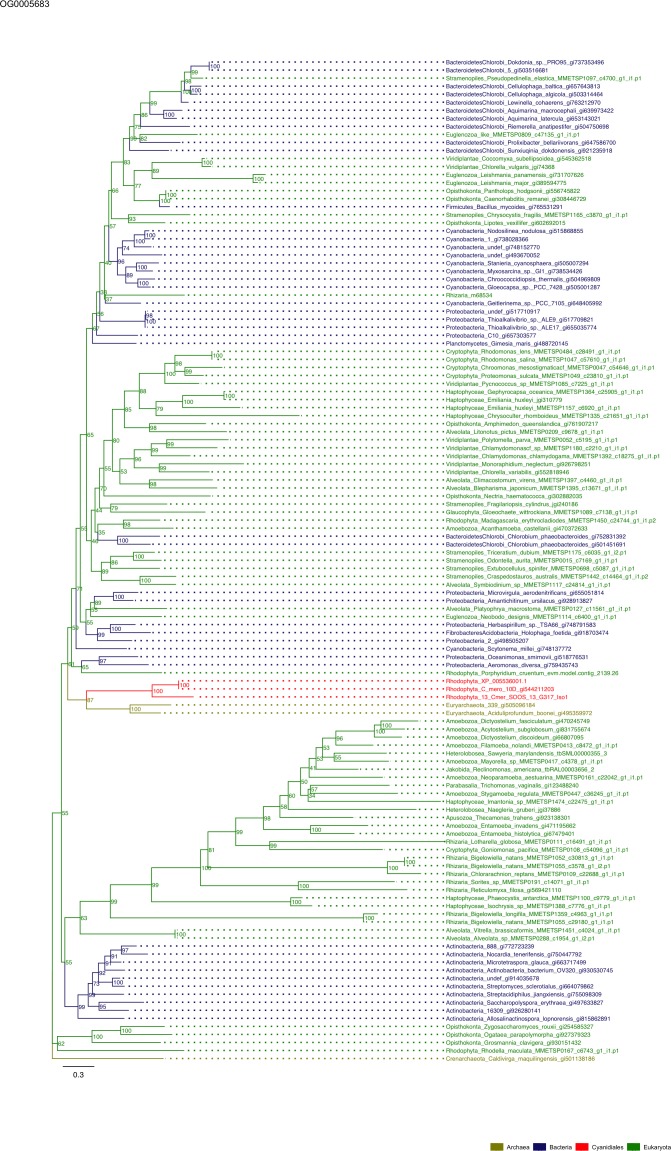
Sequence tree of orthogroup OG0005683.The tree is based on amino acid sequences. Archaea (yellow), Bacteria (blue), Cyanidiales (red), Eukaryotes including other red algae (green). Branches containing Cyanidiales sequences are highlited in red.